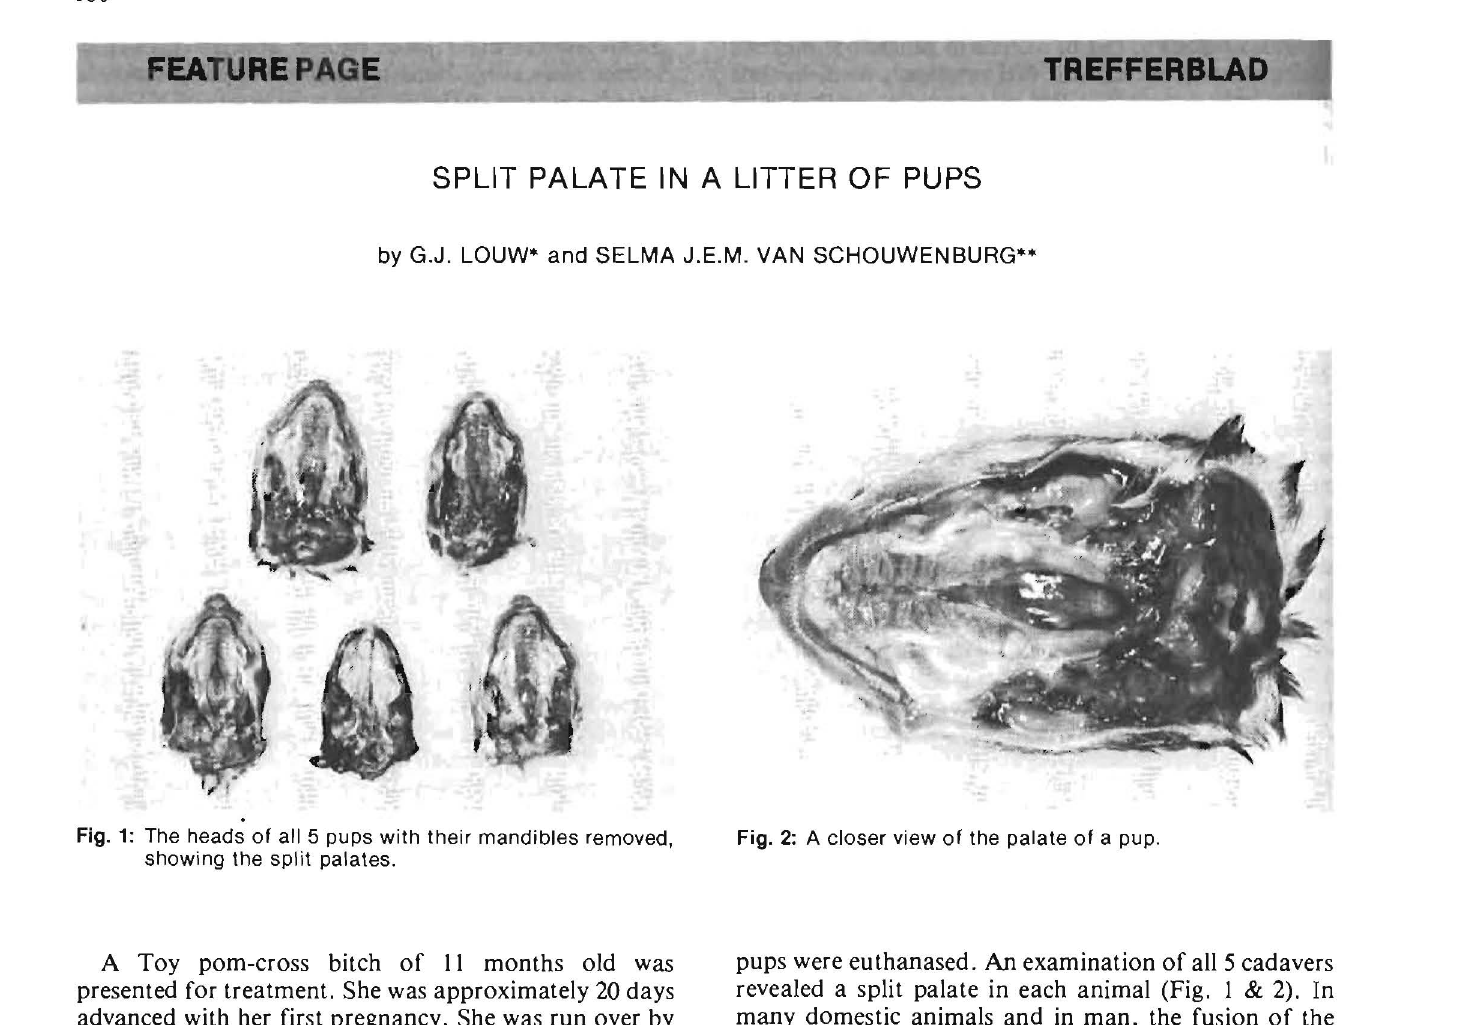
A Toy porn-cross bitch of 11 months old was presented for treatment. She was approximately 20 days